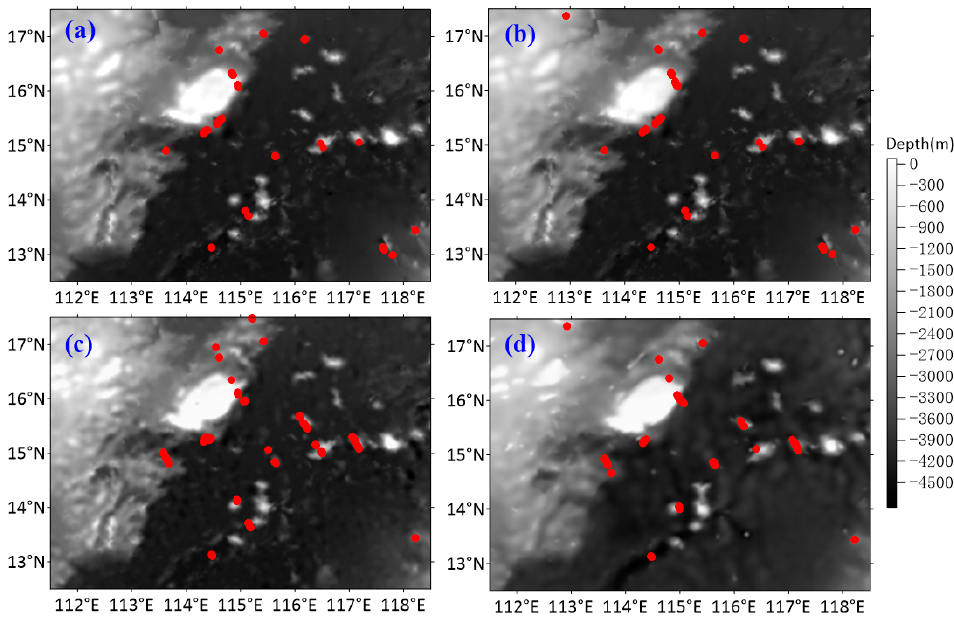
Figure 10. Results for the distribution of larger error dots: ( a ) ST1 (282), ( b ) ST2 (342), ( c ) ETOPO1 (462), and ( d ) DTU10 (316). The numbers indicate the number of error points.